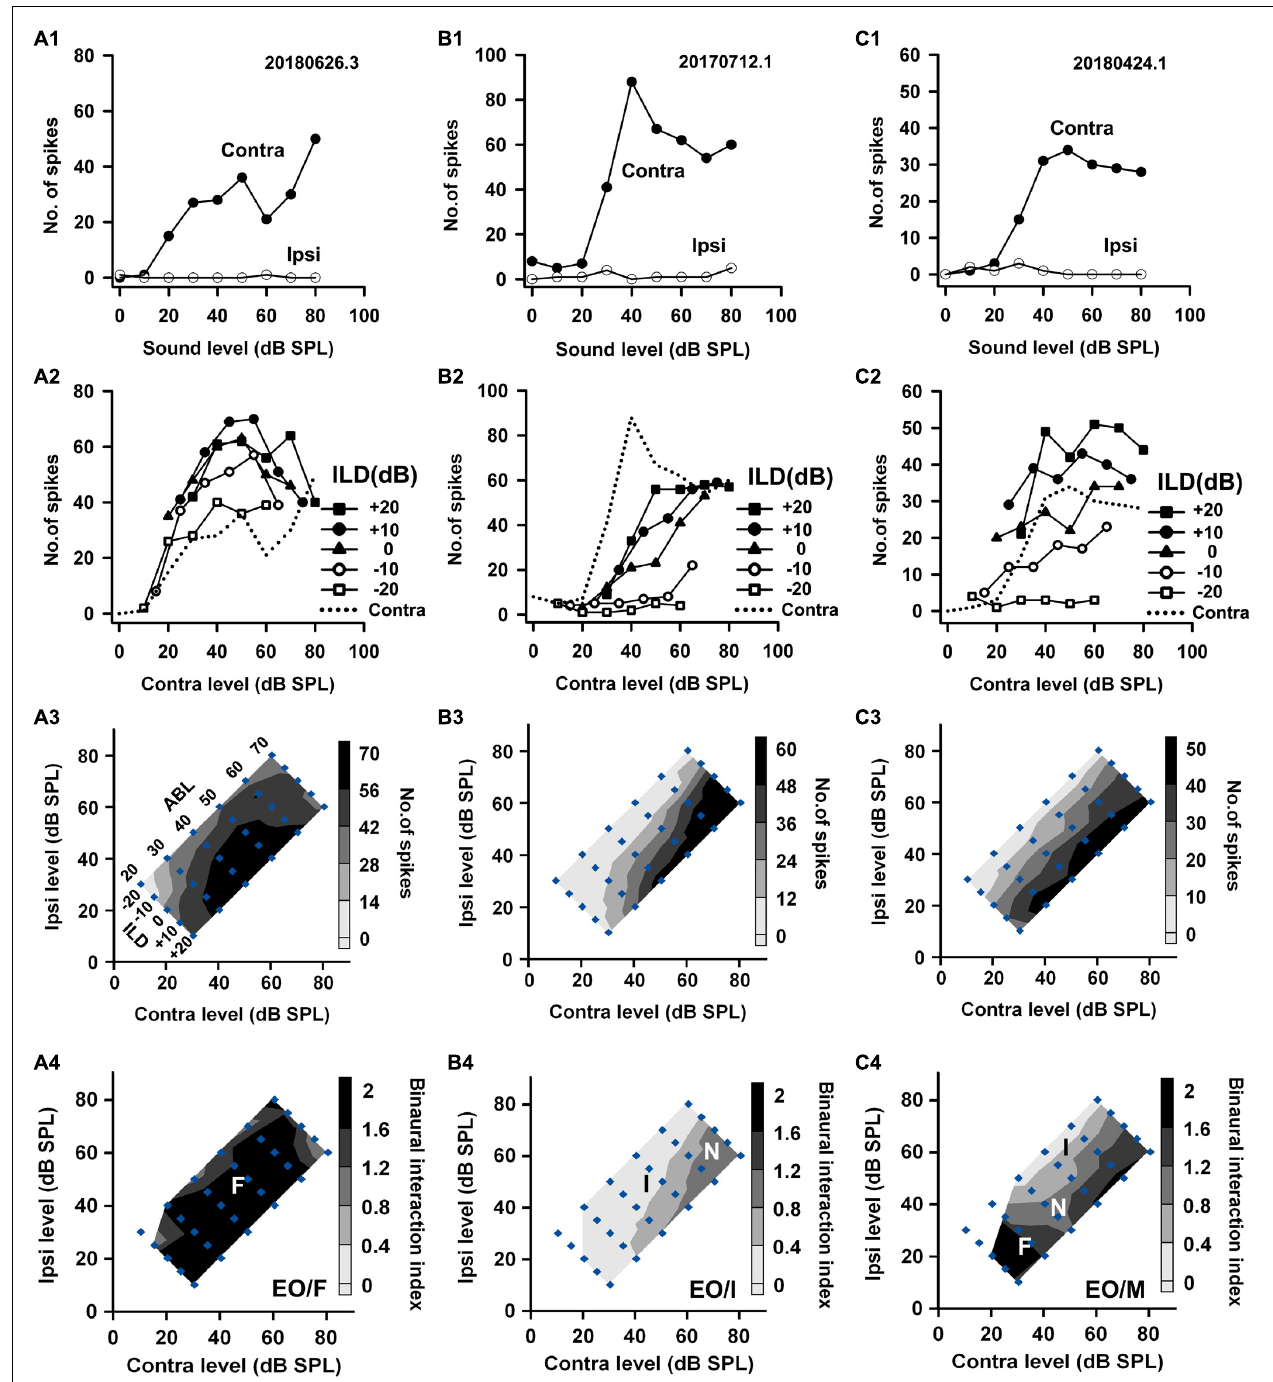
FIGURE 2 | The responses of three EO neurons to both monaural and binaural stimuli. The data shown in each column are from one neuron. (A1–C1) The monaural responses of the neurons to stimuli from the contralateral (contra) ear and the ipsilateral (ipsi) ear. (A2–C2) The binaural responses of the neurons to stimuli in the binaural stimulus matrix plotted as a function of contralateral levels and at different ILDs. For comparison, the monaural contralateral response functions are shown in dotted lines. (A3–C3) The binaural response contours plotted at different contralateral and ipsilateral levels within the binaural stimulus matrix. Filled diamonds represent binaural stimulus conditions, and the stimuli are also shown in ABL vs. ILD in panel (A3) . (A4–C4) The contour plots of the binaural interaction index within the binaural stimulus matrix. F, I, and N: facilitatory, inhibitory, and no binaural interaction in the contour plots, respectively. The binaural response type of a neuron was classified as mixed (M) if both facilitatory and inhibitory binaural interactions occurred within the binaural stimulus matrix (e.g., neuron C). The three neurons were categorized as EO/F, EO/I, and EO/M, respectively.